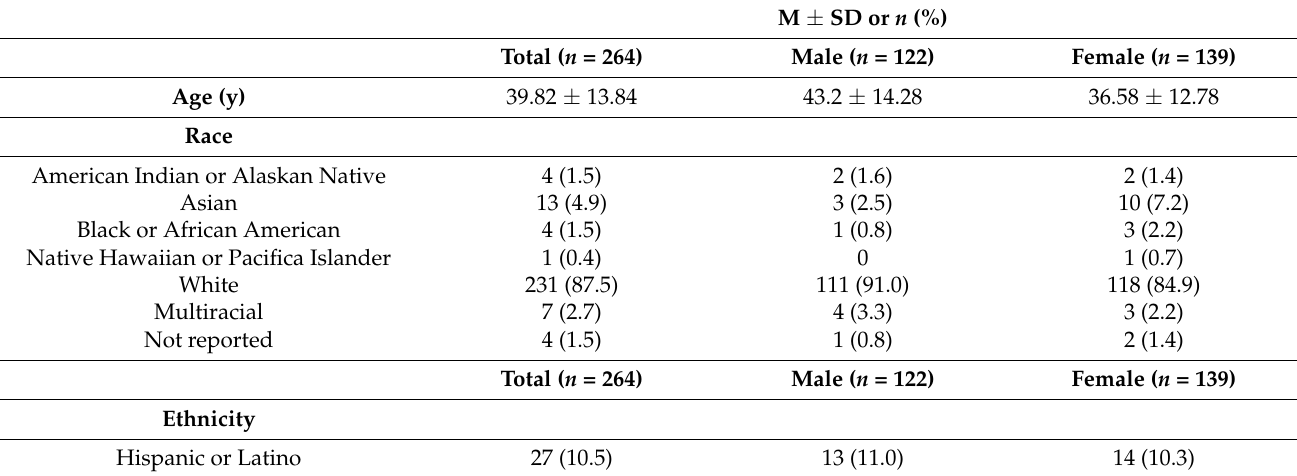
Table 1. Participant